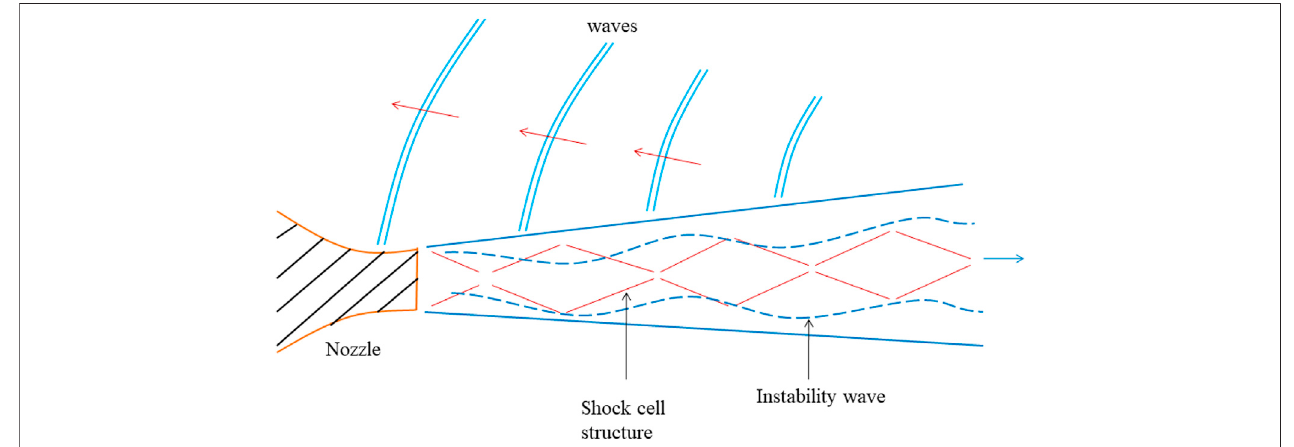
FIGURE 11 | Screech tone feedback loop